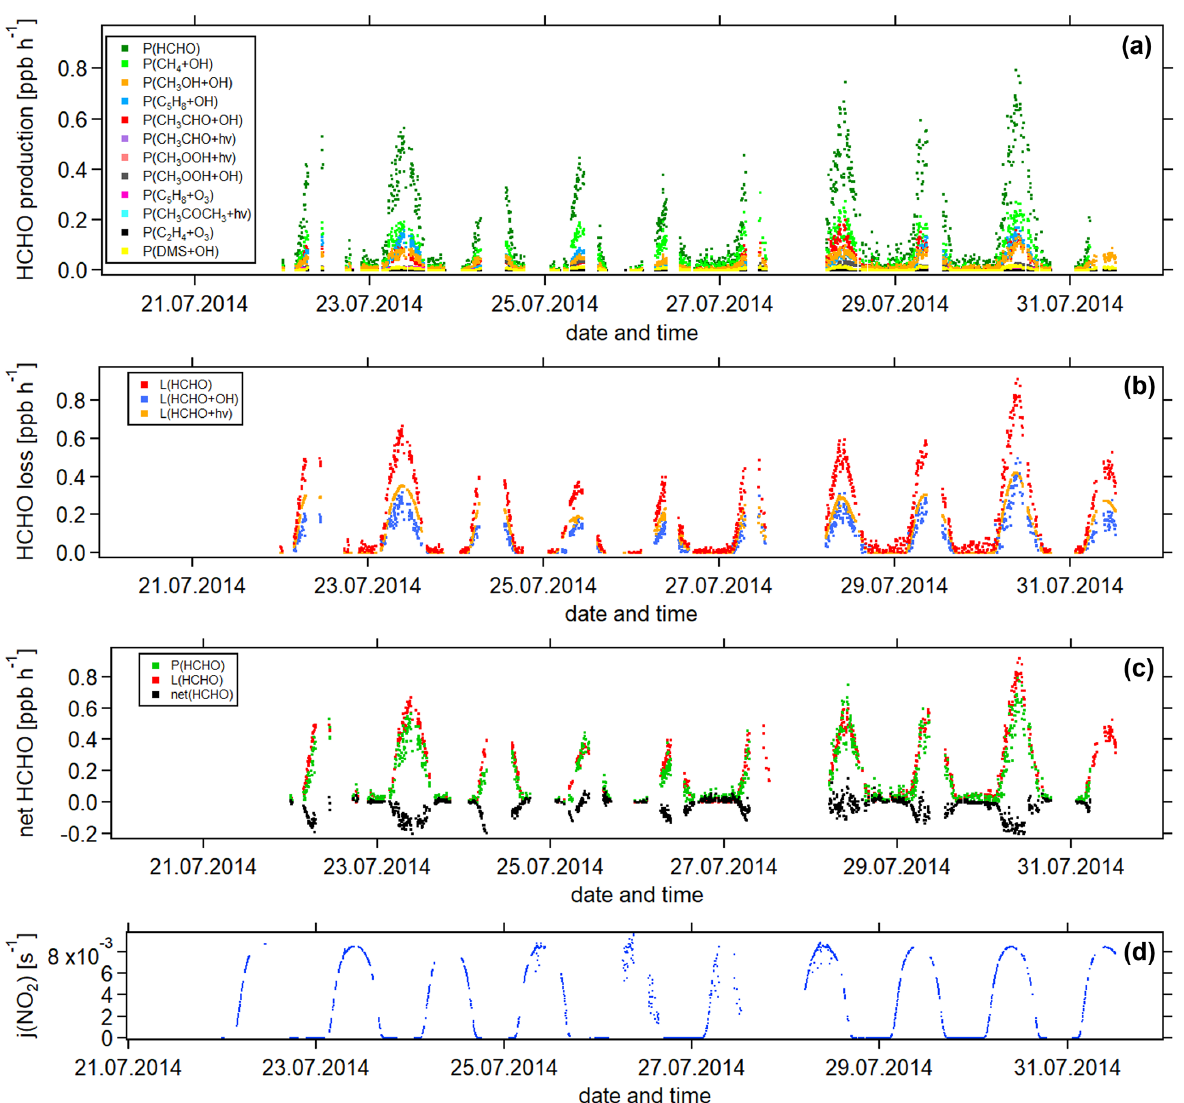
Figure 5. Temporal development of (a) HCHO production terms, (b) HCHO loss terms and (c) net HCHO from 22 July to 31 July 2014 during the CYPHEX research campaign in Cyprus. The NO 2 photolysis frequency j (NO 2 ) is shown in panel (d) as an illustration of the diurnal cycle. All times are in